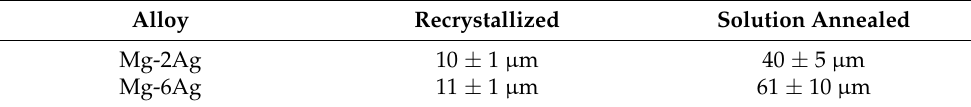
Figure 2. Micrographs of the annealed wire cross sections, ( a ) Mg-2Ag and ( b ) Mg-6Ag. A large number of twins is visible, which are introduced easily by bending especially in the annealed wires. ( c ) displays an overview of a larger part of the a Mg-2Ag wire for comparison. Table 3. Grain size of wires determined by the linear intersect method.